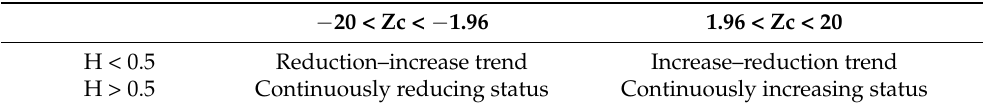
Table 2. Classification of sustainability of vegetation variations.